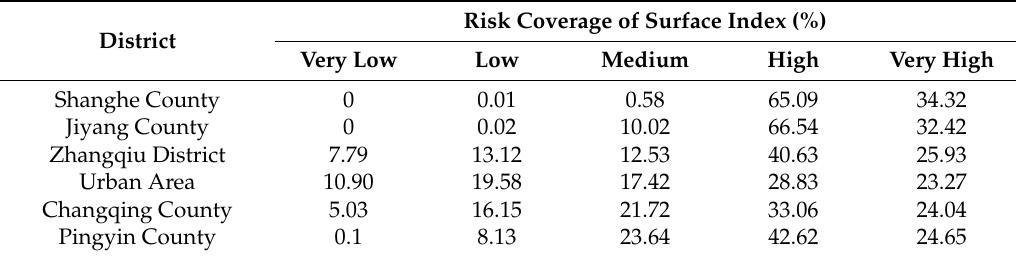
Figure 15. Spatial distribution of risk level of surface index in Jinan. Table 7. Statistical risk level of surface index in different district.